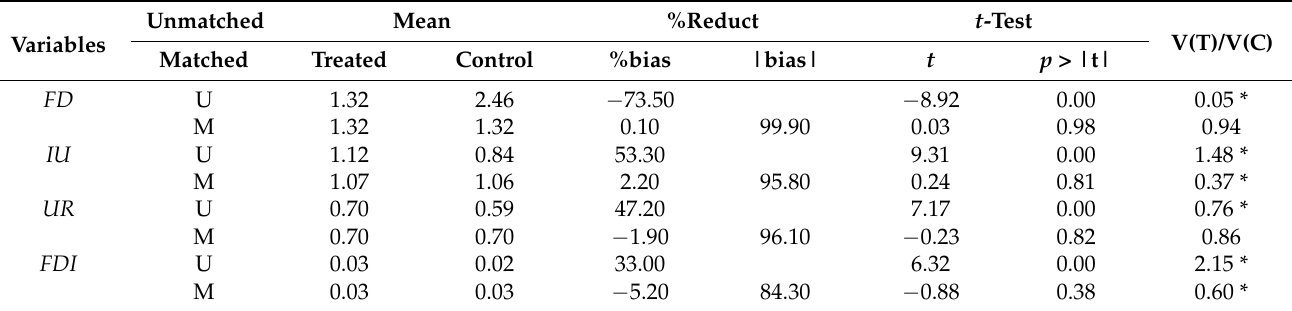
Table 3. Validity test results for tendency score